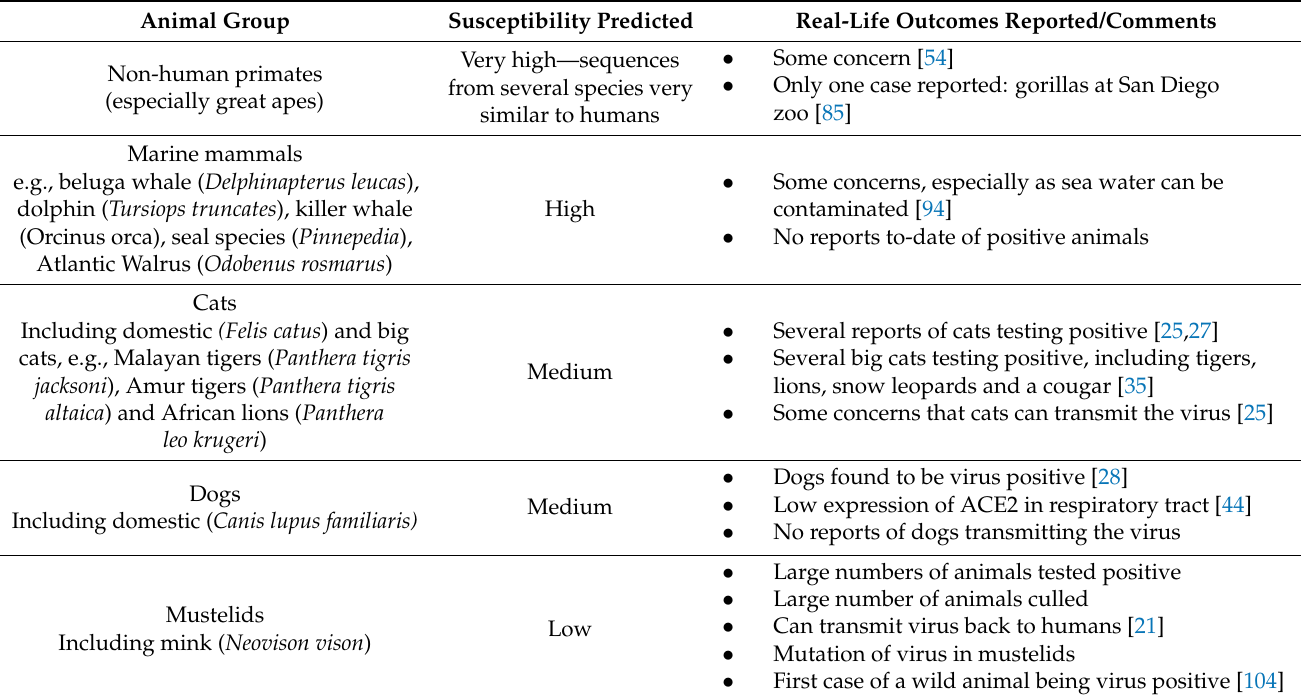
Table 4. A summary of the susceptibility predictions for a selected range of animals and how this correlates to real-life reporting